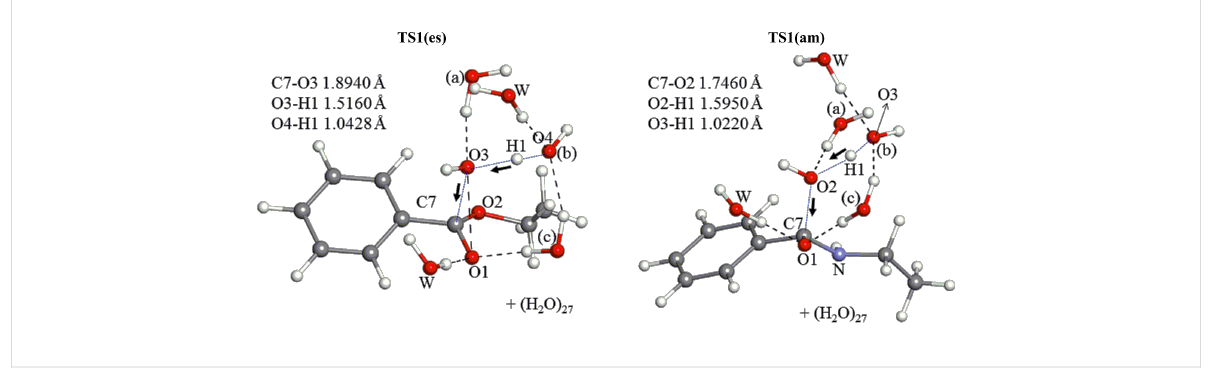
Figure 9: Central parts of the geometries of TS1(es) and TS1(am) of n = 32, which are taken from Figure 2 and Figure 3, respectively. Notations, (a), (b), (c) and W, are defined in Figure 1.